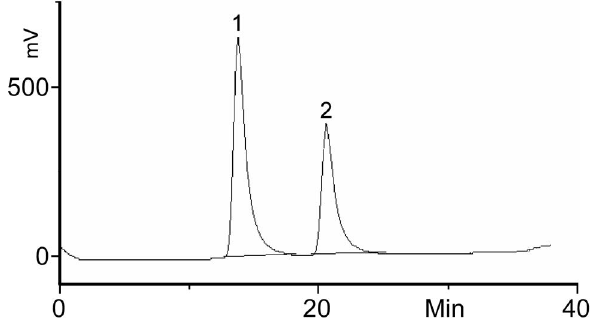
Figure 2. HPLC chromatogram of the mixture resulting from the reaction with rat liver 2,3-sialyltransferase; BODIPY-GM1 (76 m M) and CMP-NANA (144 m M) were incubated with rat liver 2,3-sialyltransferase (1.4 mU) for one hour at 37 6 C. The sample was snap-frozen, freeze-dried and dissolved in chloroform/methanol. The solution was analysed by HPLC. The product (peak 2) eluted after the acceptor substrate (peak 1) with baseline separation. doi:10.1371/journal.pone.0094206.g002 PLOS ONE |